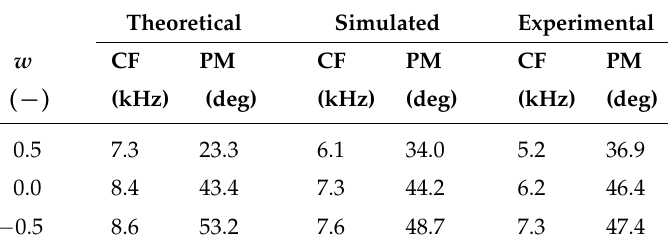
Table 2. Crossover frequency (CF) and phase margin (PM) for different values of w (with β = 0.85 and k n =